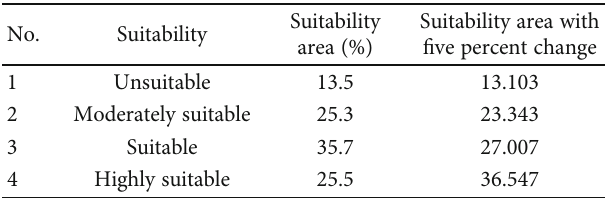
Table 17: Suitability area percentage of sensitivity analysis for one percent change in solar irradiance.